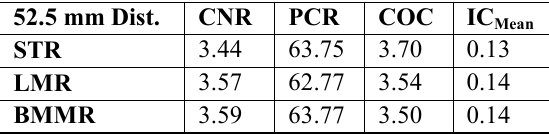
Table-9: CNR, PC R and COC of the conductivity images of Fig. -13 52.5 mm Dis t .